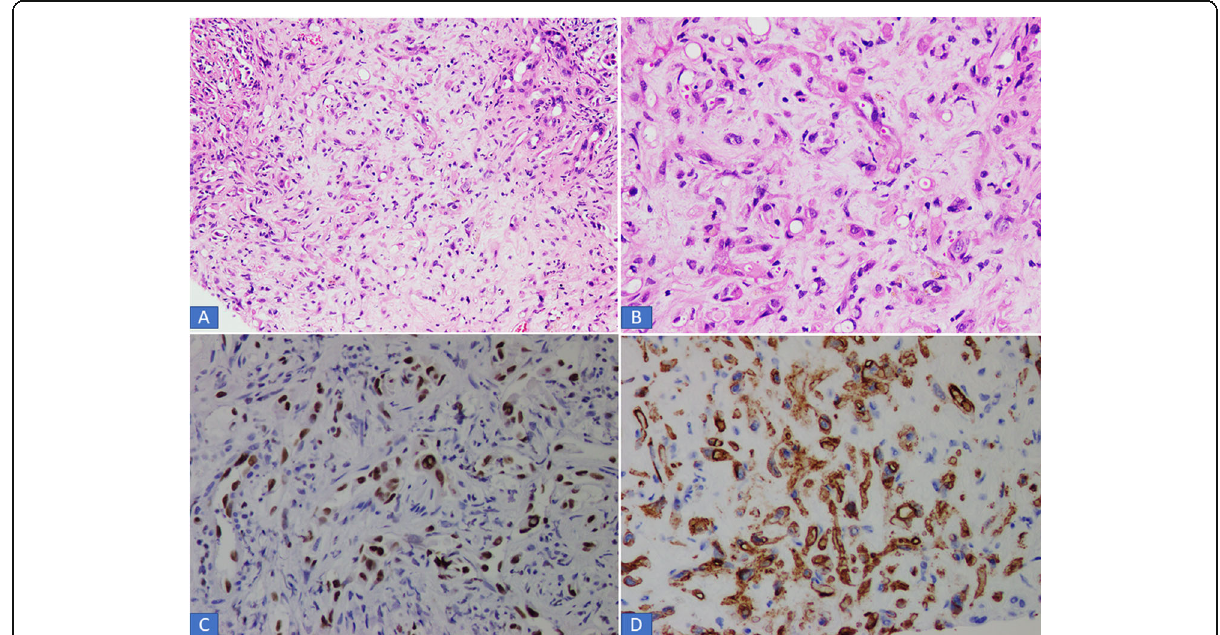
Fig. 2 a-b . Intermediate and high-power examination of hepatic EHE. The tumors cells are present in a myxohyaline stroma. Cords of epithelioid cells are seen exhibiting cytoplasmic vacuoles and hyperchromatic nuclei. The tumor cells are positive for ERG c and CD34 d immunohistochemical